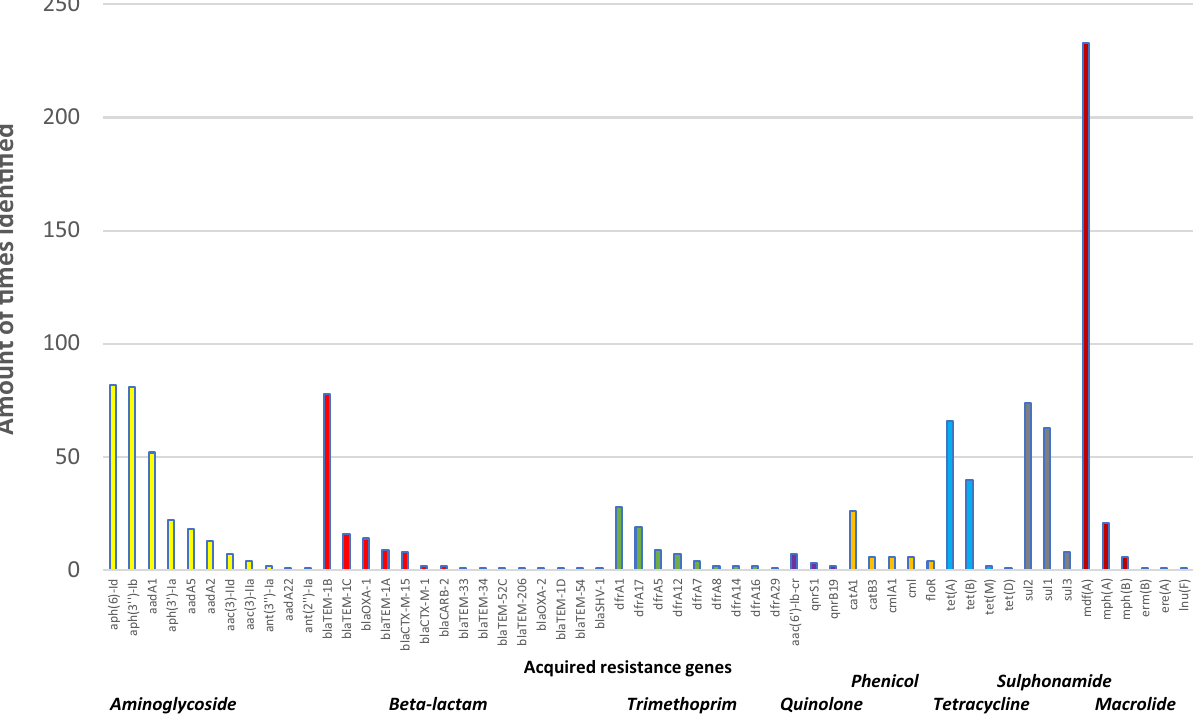
Figure 1. Identified acquired resistance genes from 234 E. coli isolates isolated from bloodstream infections between 1985 and 2018. From left to right: resistance genes against aminoglycosides (yellow), beta-lactams (pink), trimethoprim (green), quinolones (purple), phenicol (orange), tetracyclines (blue), sulphonamides (grey) and macrolides (red). Genes responsible for resistance to the 11 tested antibiotics are summarized in the Supplementary Data